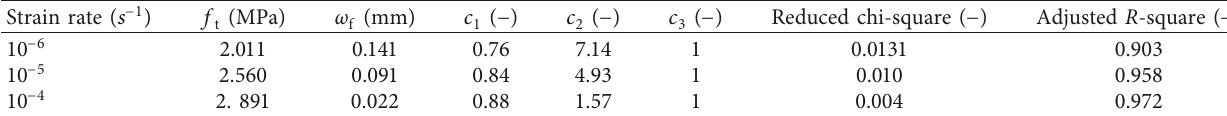
Table 2: Equation parameters of the fitting curve of new function and fracture energy.